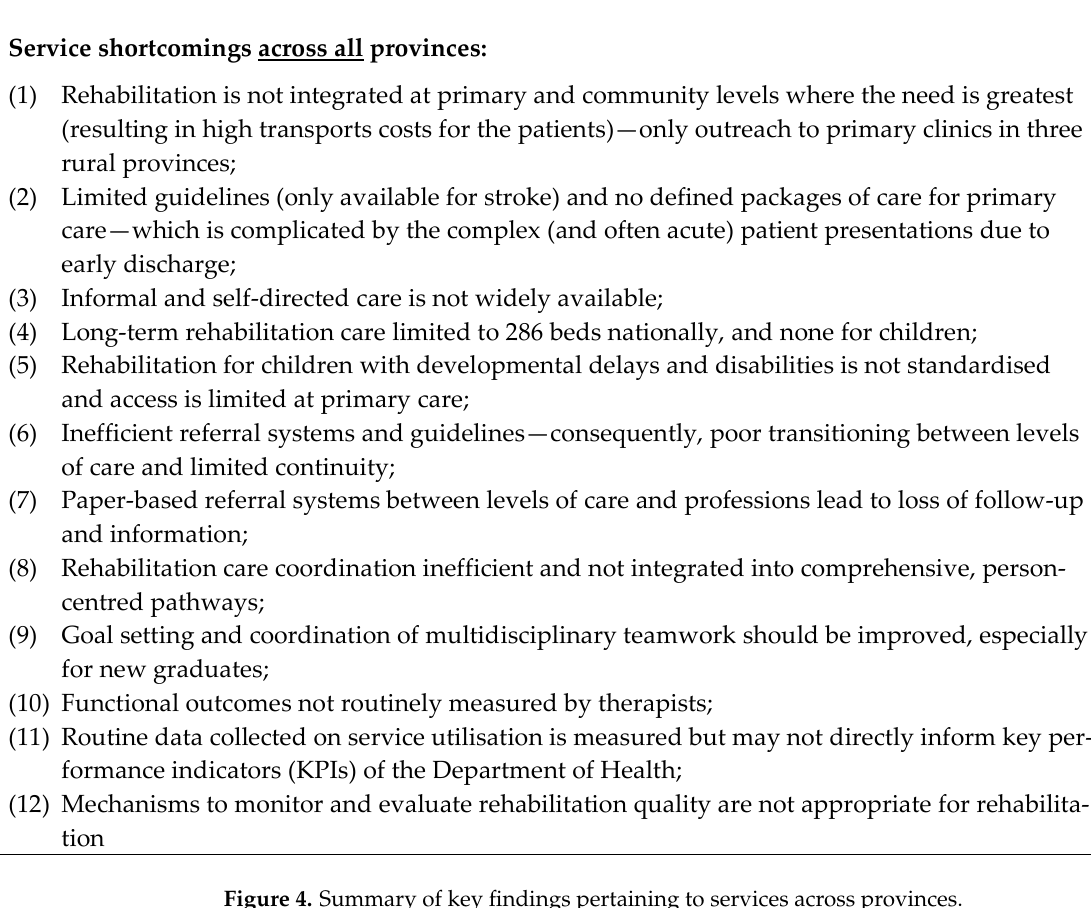
Figure 4. Summary of key findings pertaining to services across provinces.